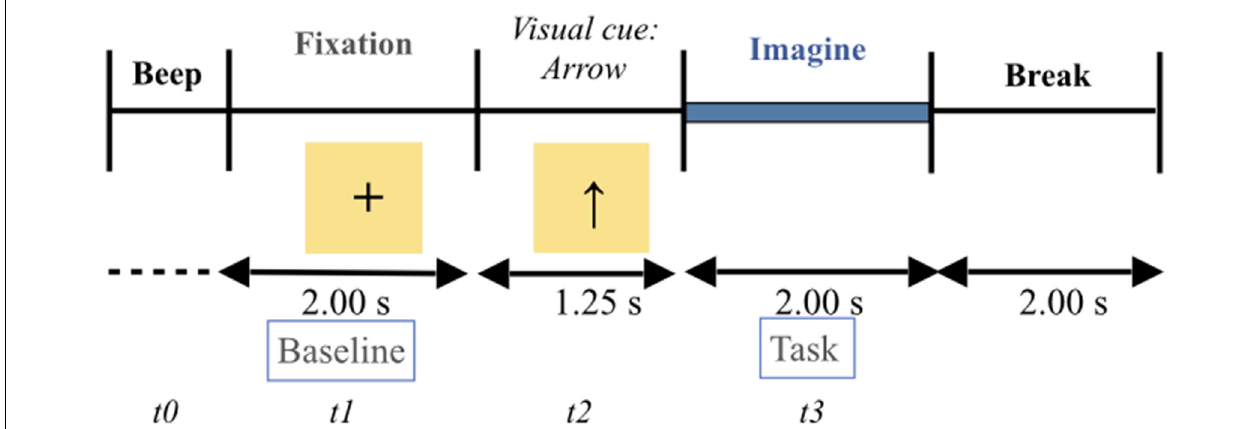
FIGURE 1 | Timing presentation of the four motor imagery experimental paradigm. The start of each trial was signified by the presence of a short “beep tone”. This corresponds to t = 0. Immediately, a fixation cross appeared in the middle of the screen for 2 s, i.e., t = 1, fixation cross. The 2 s duration time constitutes the baseline. After these 2 s, an arrow indicating either left, right, up, or down direction appeared for 1.25 s on the screen. The arrow is the visual cue, i.e., t = 2. By definition, each direction of the arrow corresponds to a body part, as follows: left arrow ← left hand (i.e., task 1), right arrow → right hand (i.e., task 2), up arrow ↑ tongue (i.e., task 3), and down arrow ↓ feet (i.e., task 4). Each arrow required the participant to perform the corresponding MI task. Once the arrow disappeared from the screen, each participant, facing the black screen, performed a MI task, one at a time, for 2 s, i.e., t = 3. At the end of each motor imagery task, each participant was allowed to take a break and relax. The inter-trial interval was around 2 s.